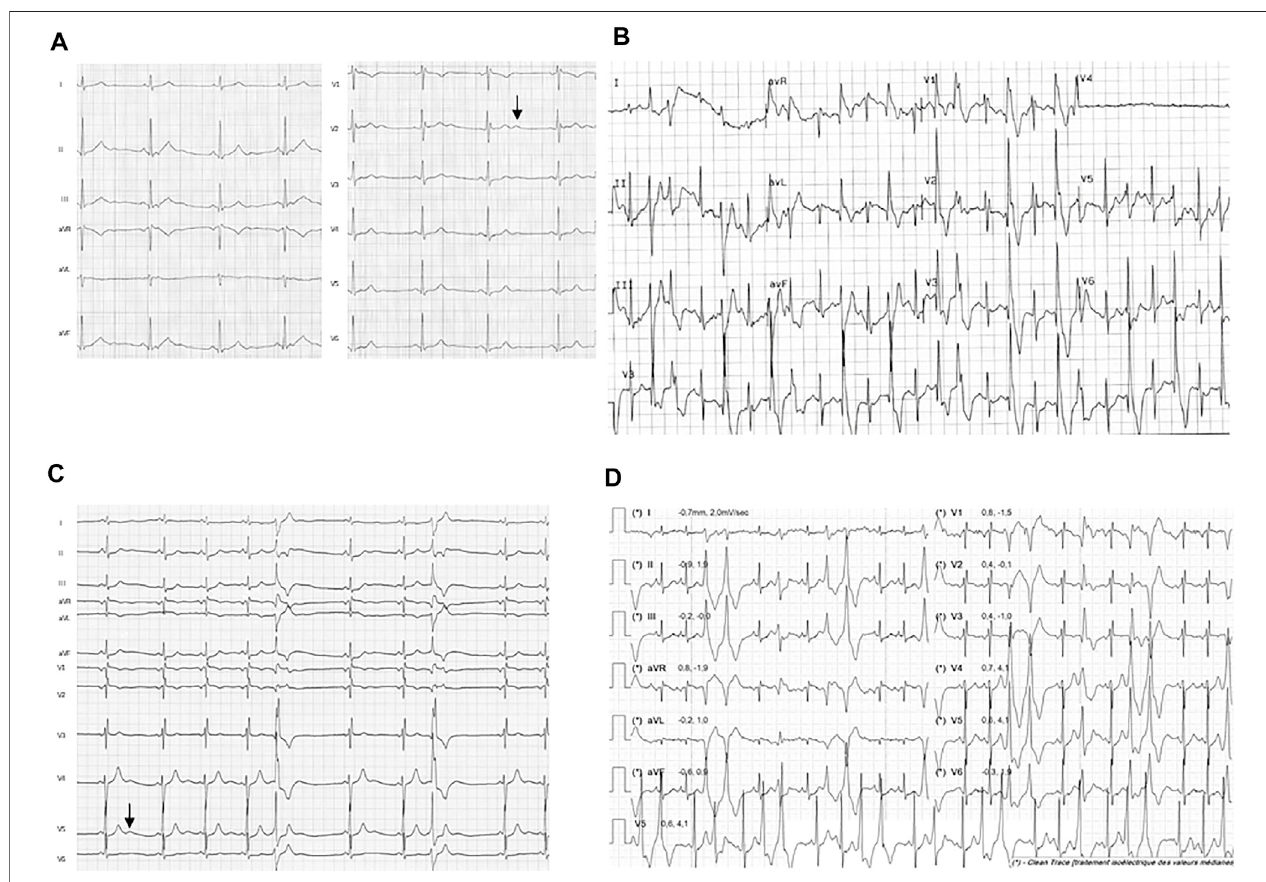
FIGURE 1 | Resting ECG and exercise ECG from the probands 1 and 2. Traces from proband 1 shows (A) resting ECG with U wave (arrow) and (B) PVCs during exercise test (120 W workload). Traces from proband 2 shows (C) resting ECG with U wave (arrow) and (D) polymorphic PVCs at exercise (50 W workload) during the fi rst Cardiopulmonary exercise test (CPET) before medical treatment was